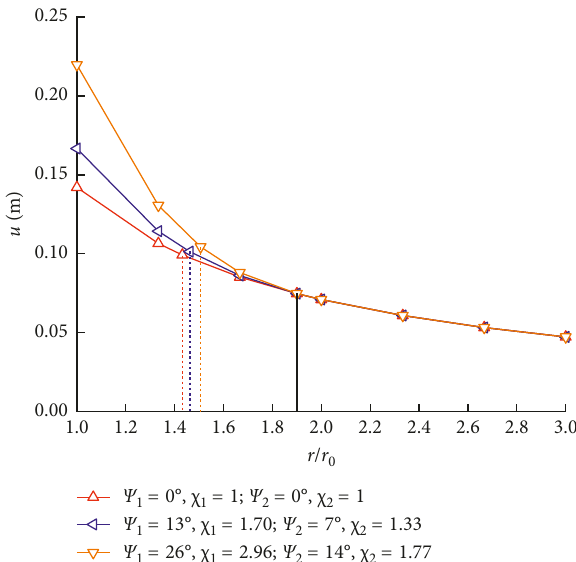
Figure 10: The influence of dilatancy on the plastic zone radius and